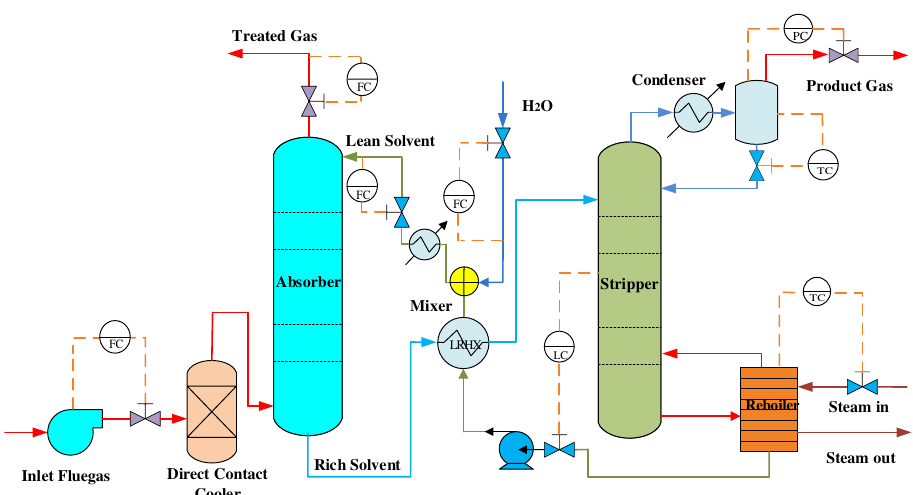
Figure 2. Schematic of the capture device after combustion CO 2 amine-based power